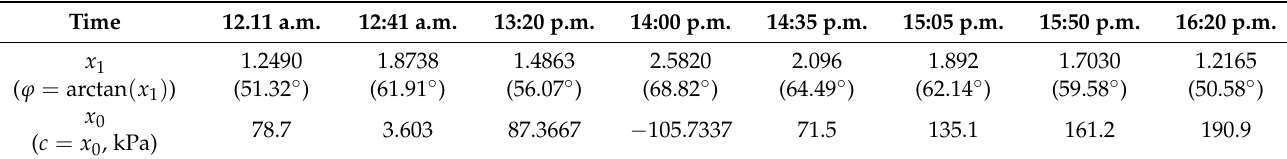
Table 5. The regression coefficients obtained by the proposed regression analysis.